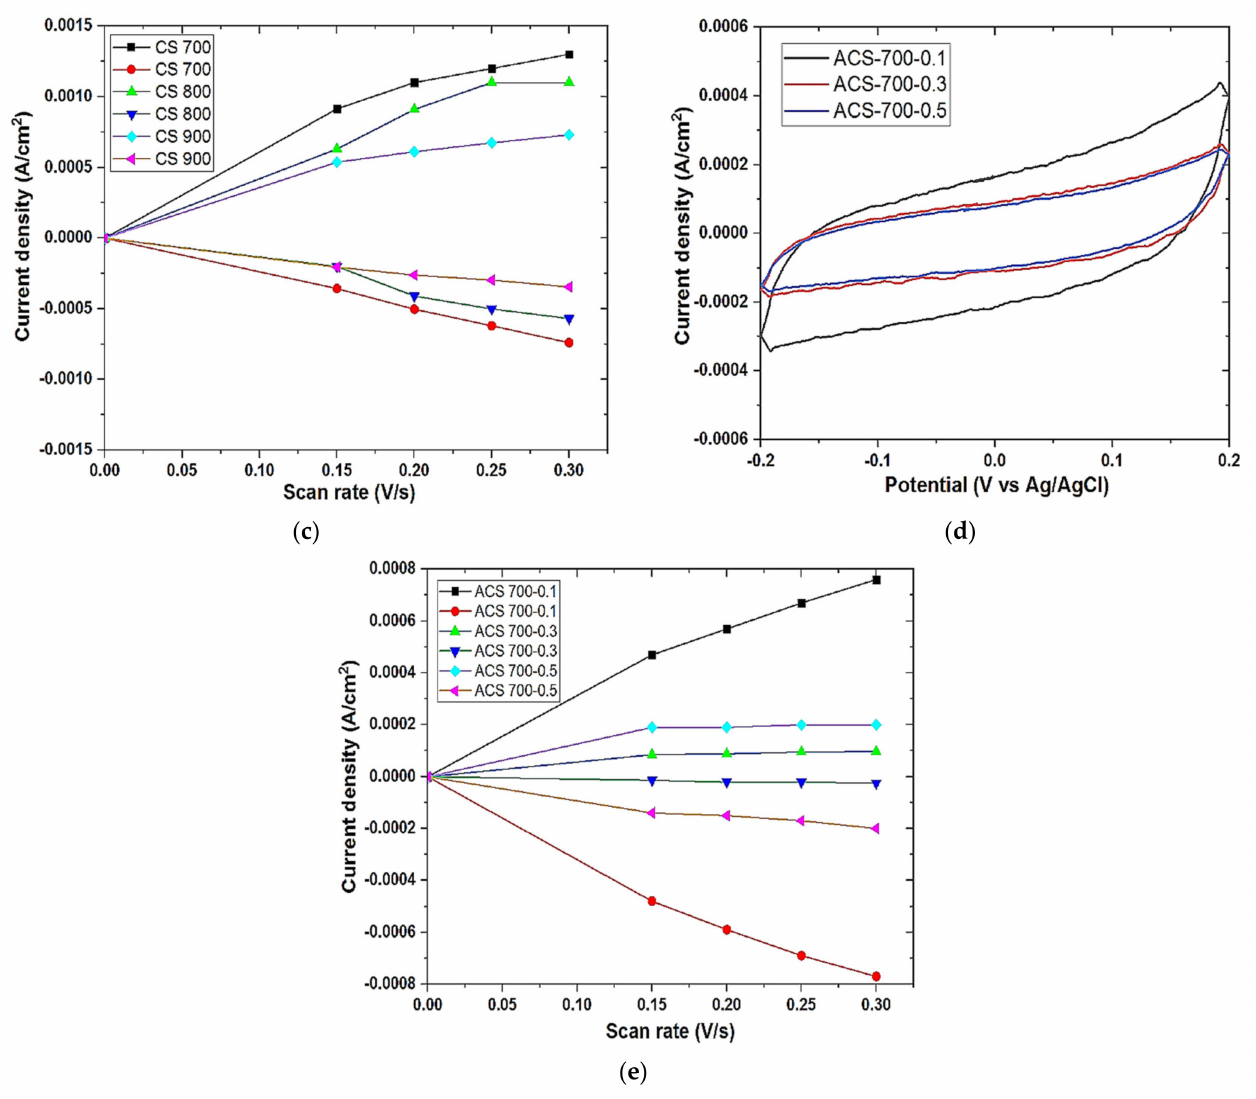
Figure 6. Galvanostatic charge–discharge ( a ) of CS 700, CS 800, and CS 900; ( b , d ) cyclic voltammetry curve of CS 700, CS 800, CS 900, ACS 700 − 0.1, ACS 700 − 0.3, and ACS 700 − 0.5 at the scan rates of 50 mV/s respectively; ( c , e ) double-layer capacitance voltammetry measurements of CS 700, CS 800, CS 900, ACS 700 − 0.1, ACS 700 − 0.3, and ACS 700 − 0.5 respectively. Cyclic voltammetry measurements were carried out in 1 M NaCl aqueous electrolyte and measured in a non-Faradaic region of the voltammogram at high scan rates of 150–300 mV s − 1 . The charging current (ref current density above 0 A cm − 2 ) and discharging current (ref. current density below 0 A/cm 2 ) were plotted as a function of scan rate (V s − 1 ). The determined double-layer capacitance of the system was taken as the absolute value of the slope fits to the data